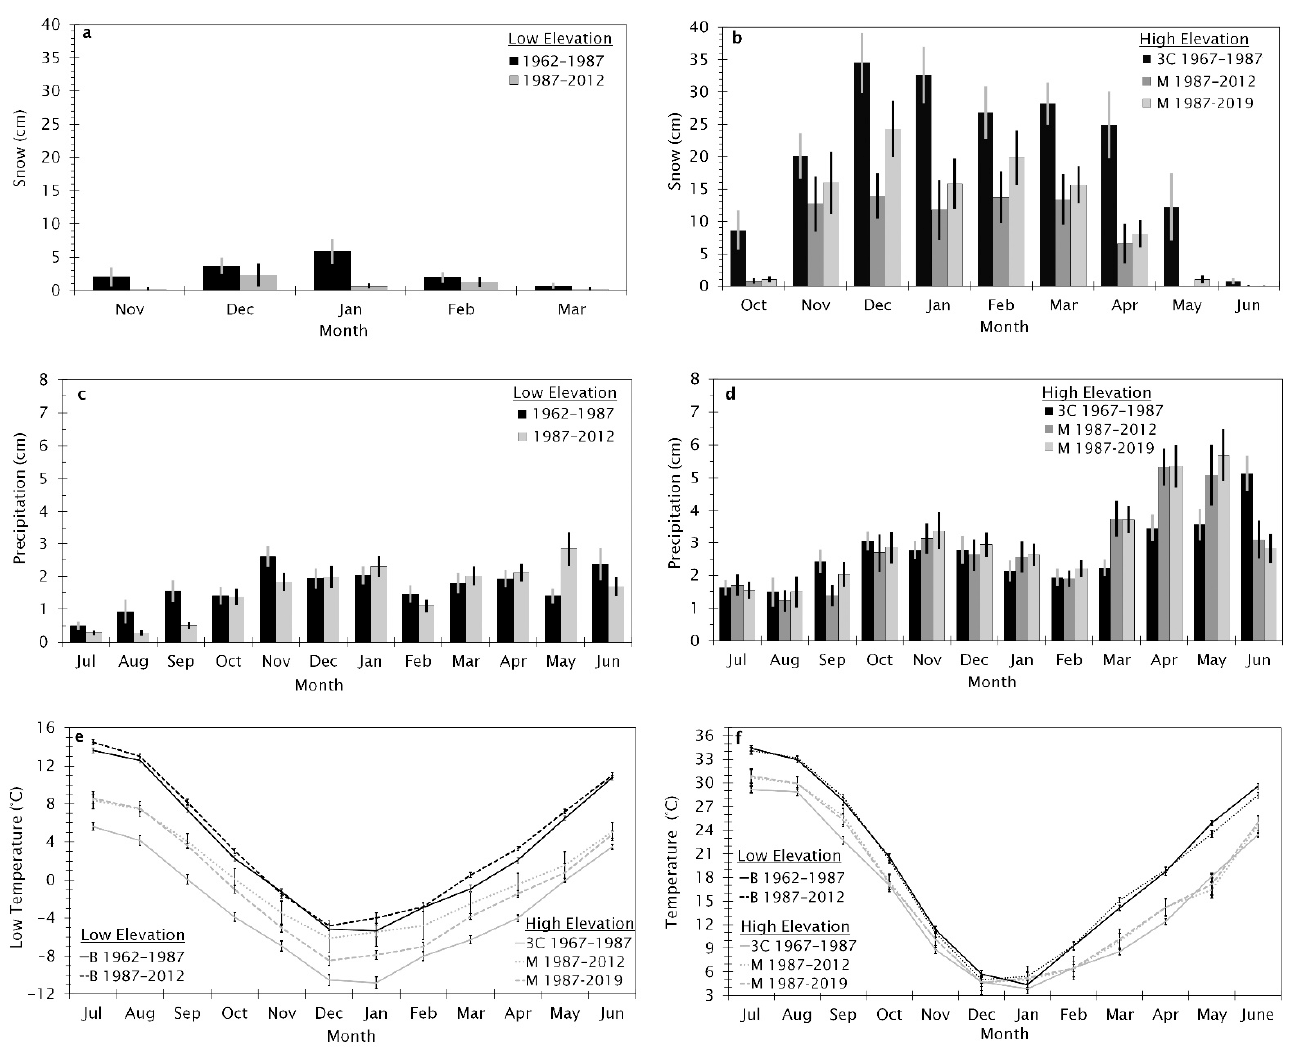
Figure 2. The 25-year mean ( ± SE) monthly climate data for the low and high elevation sites in our study area. The snowfall ( a,b ) and precipitation ( c,d ) near low ( a,c ) and high elevation ( b,d ) sites. The average monthly mean low temperatures ( e ) and high temperatures ( f ) for low and high elevation sites. Low elevation climate data from Remote Automated Weather Stations in Bruneau, Idaho (770 m, station ID 101195); high elevation climate data for 1962–1987 from Three Creek, Idaho (3C, 1655 m, station ID 109119) and after 1987 from Murphy Hot Springs, Idaho (M, 1572 m, station ID 106250). We downloaded data from the Western Regional Climate Center at the Desert Research Institute (https://wrcc.dri.edu/summary/Climsmsid.html (accessed on 1 March 2015)). The Bruneau RAWS recorded data from 1962 to 2012 with the mean monthly averages based on a sample size of 23–25 years for each period. The Three Creek RAWS site was discontinued in 1987; the monthly average was based on a sample size of 20–25 years. The Murphy RAWS was the nearest location to Three Creek and established in December 1987. Missing data between 1987 and 2012 resulted in a smaller sample size (n = 12–15 years); we include data from 1987 to 2019 to increase the sample size (n = 20–23 years), so the data would be based on similar numbers of years as both Bruneau and Three